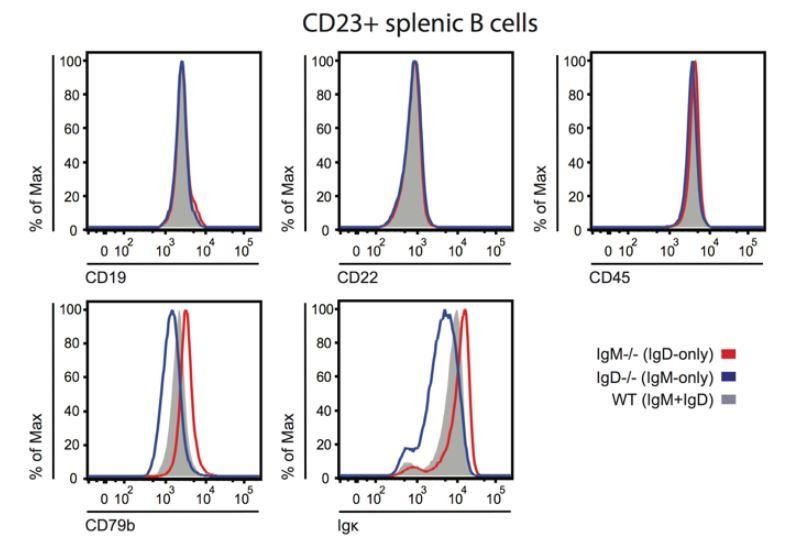
BCR, co-receptor and CD45 expression on IgM or IgD-deficient B cells.Splenocytes from IgM-/-, IgD-/-, or WT ice were stained to detect surface expression of CD19, CD22, CD45, CD79b, and kappa light chain. Histograms depict CD23+ splenocyte gate. Differences in surface kappa expression between genotypes consistent with Figure 1D, Figure 1—figure supplement 2B, C.